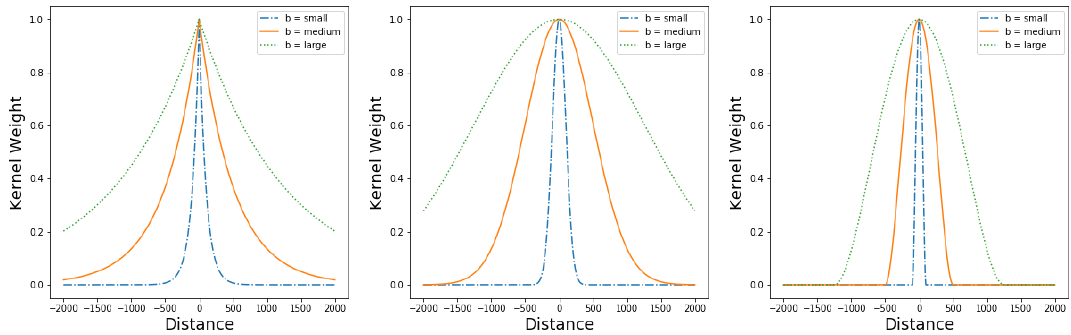
Figure 3. Examples of exponential kernels ( top ), Guassian kernels ( middle ), and bisquare kernels ( bottom ) for a small, medium, and large bandwidth parameter.